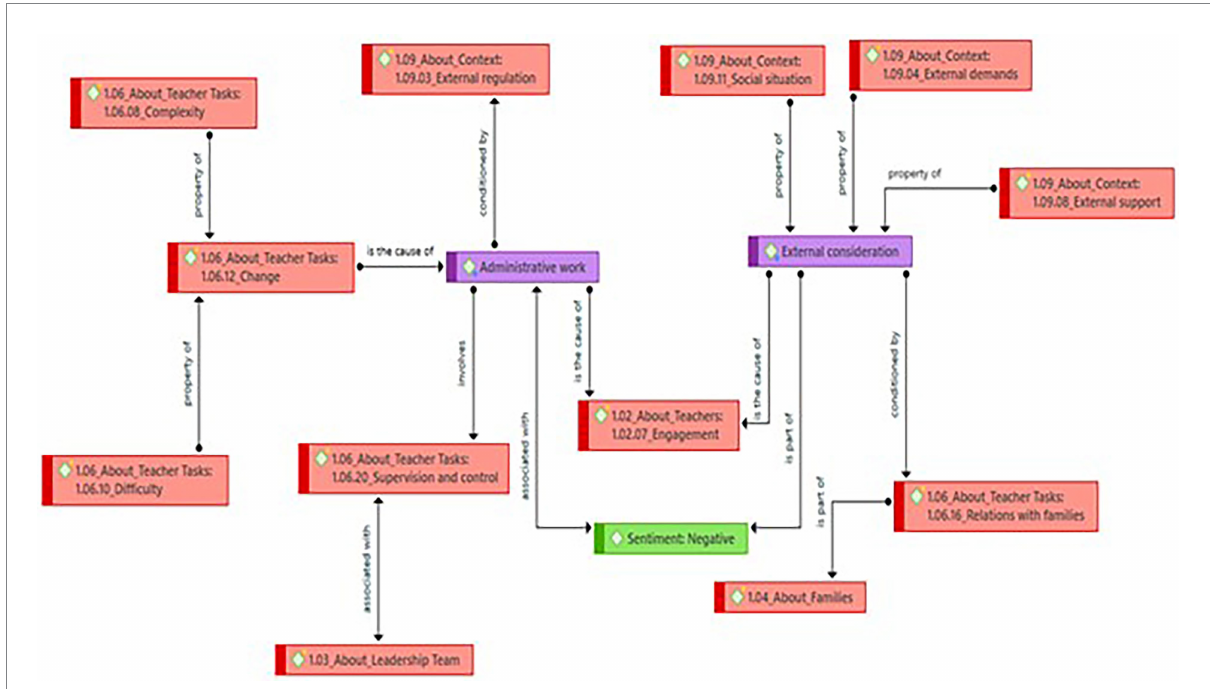
FIGURE 6 Semantic network of relationships between central categories and associated